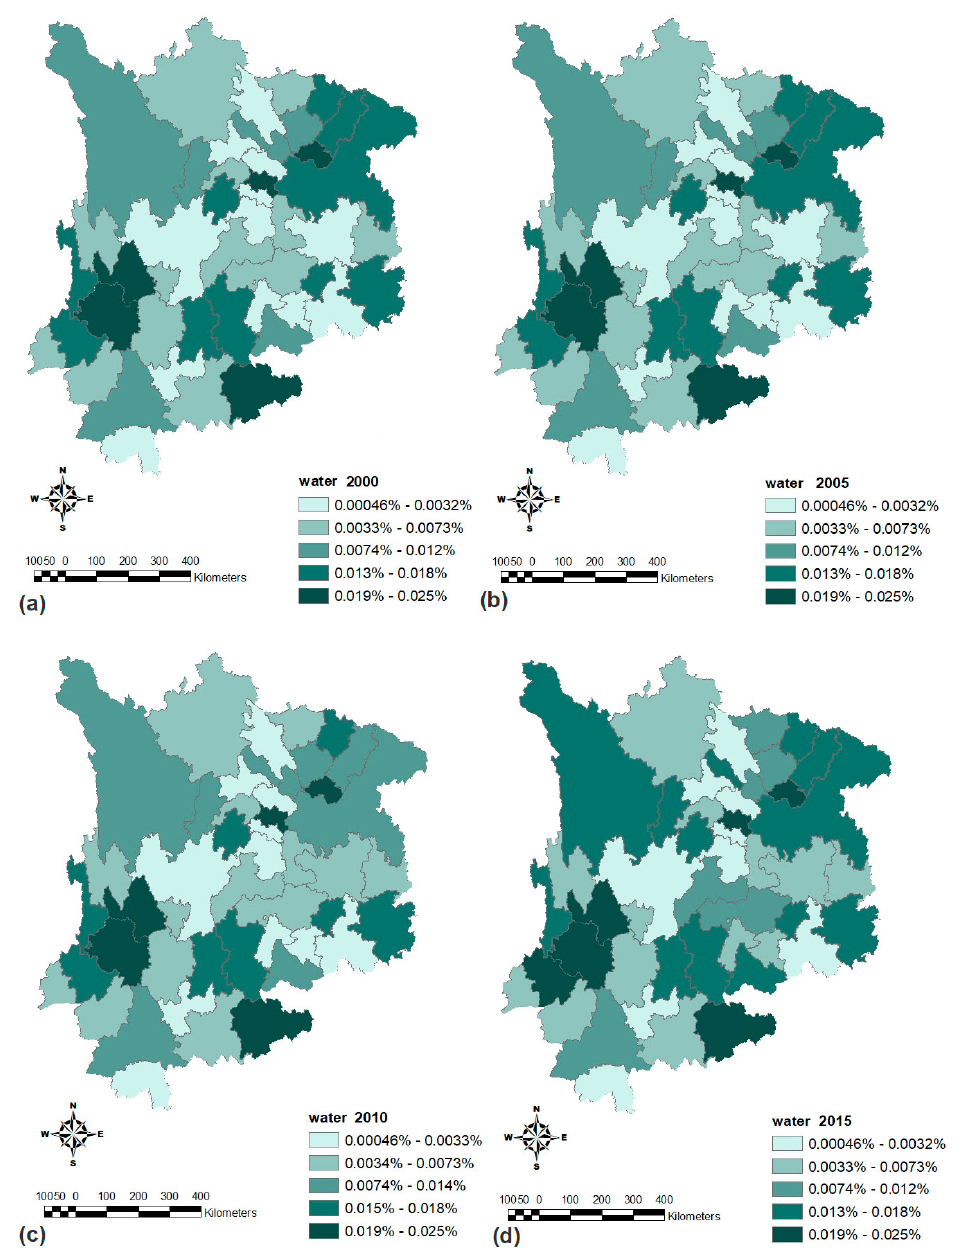
Figure 6. The proportion of water bodies in different cities in four different years: ( a ) 2000; ( b ) 2005; ( c ) 2010; and ( d ) 2015.